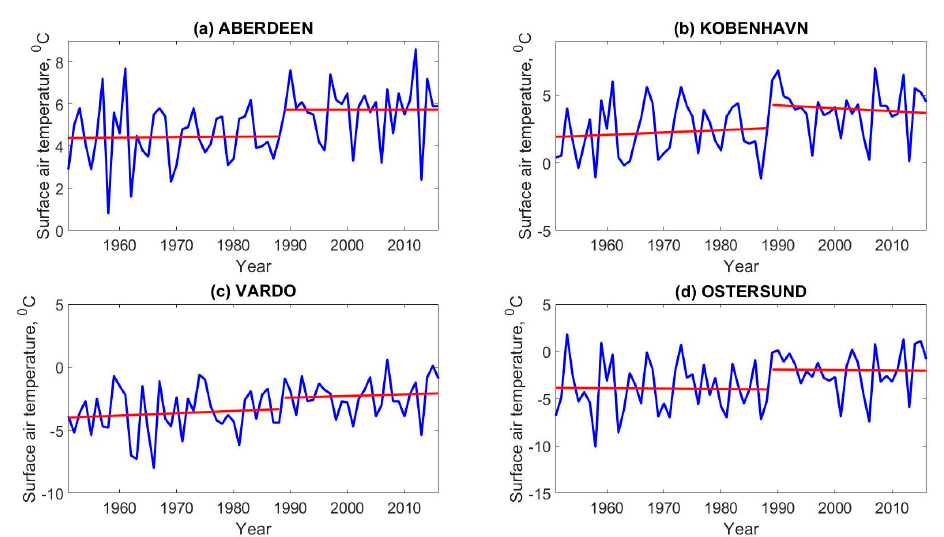
Figure 5. The model of stepwise changes for the SAT in March at the weather stations ( a ) Aberdeen, ( b ) Kobenhavn, ( c ) Vardo and ( d ) Ostersund. The di ff erences in the mean temperatures for the weather stations with the year of stepwise changes in 1989 are summarized in Table 7. Table 7. Assessment of the warming in Northern Europe based on the divided trends (1951–2016 period, March). Year of Stepwise